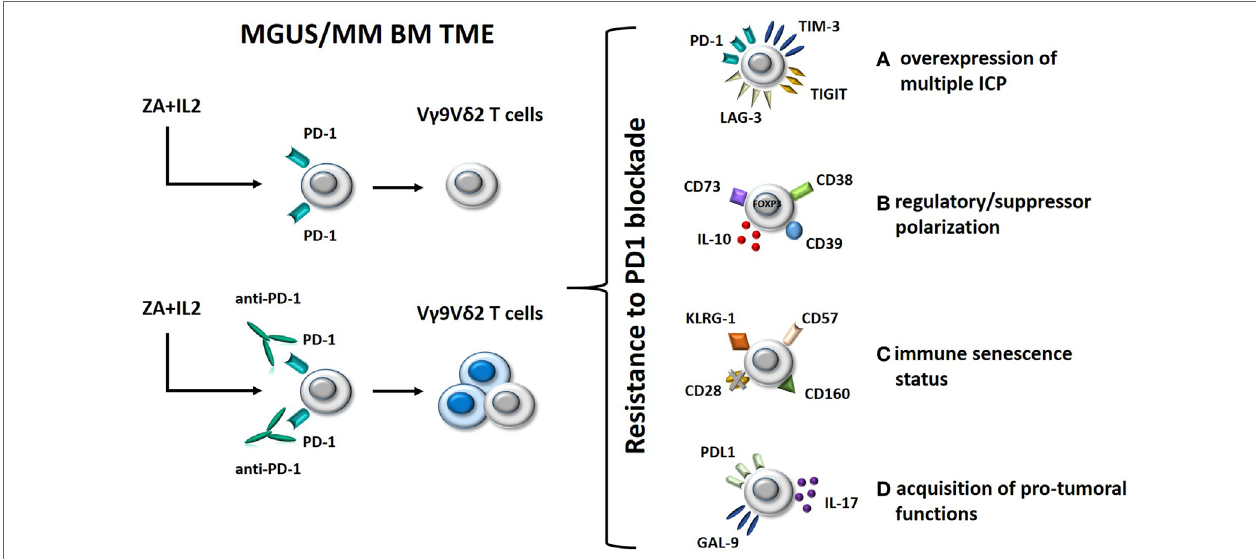
FigURe 2 | Hypothetical mechanisms of resistance to PD-1 blockade in BM V γ 9V δ 2 T cells from MM patients. Left panel: BM V γ 9V δ 2 T cells in MGUS and MM are anergic to ZA + IL-2 stimulation; this anergy is only partially rescued by single agent PD-1 blockade. Right panel: possible mechanisms of resistance to immune recovery triggered by single agent PD-1 blockade. (A) Alternative inhibitory ICPs, such as TIM-3, TIGIT, and LAG-3, are expressed by BM V γ 9V δ 2 T cells to reinforce their anergy and resist to PD-1 blockade; (B) V γ 9V δ 2 T cells have been functionally polarized to express inhibitory molecules (FOXP3, CD73, CD39, and CD38) and release immune suppressive cytokines (IL-10) as a consequence of their long-term exposure to tumor cells in the BM; (C) BM V γ 9V δ 2 T cells have acquired a senescence status (CD57 + CD160 + KLRG-1 + CD28 − phenotype) which is hard to reverse by single PD-1 blockade; (D) PD-1 engagement of anergic/senescent BM V γ 9V δ 2 T cells induces the expression of PD-L1 and galectin-9 (GAL-9), and IL-17 secretion leading to immune suppressive effects on other effector cells like CD8 + cells. Abbreviations: MGUS, monoclonal gammopathy of undetermined significance; MM, multiple myeloma; BM, bone marrow; TME, tumor microenvironment; ZA, zoledronate; IL-2, interleukin 2; ICP, immune checkpoint; TIM-3, T-cell immunoglobulin and mucin-domain containing-3; LAG-3, lymphocyte-activation gene 3; PD-1, programmed cell death protein